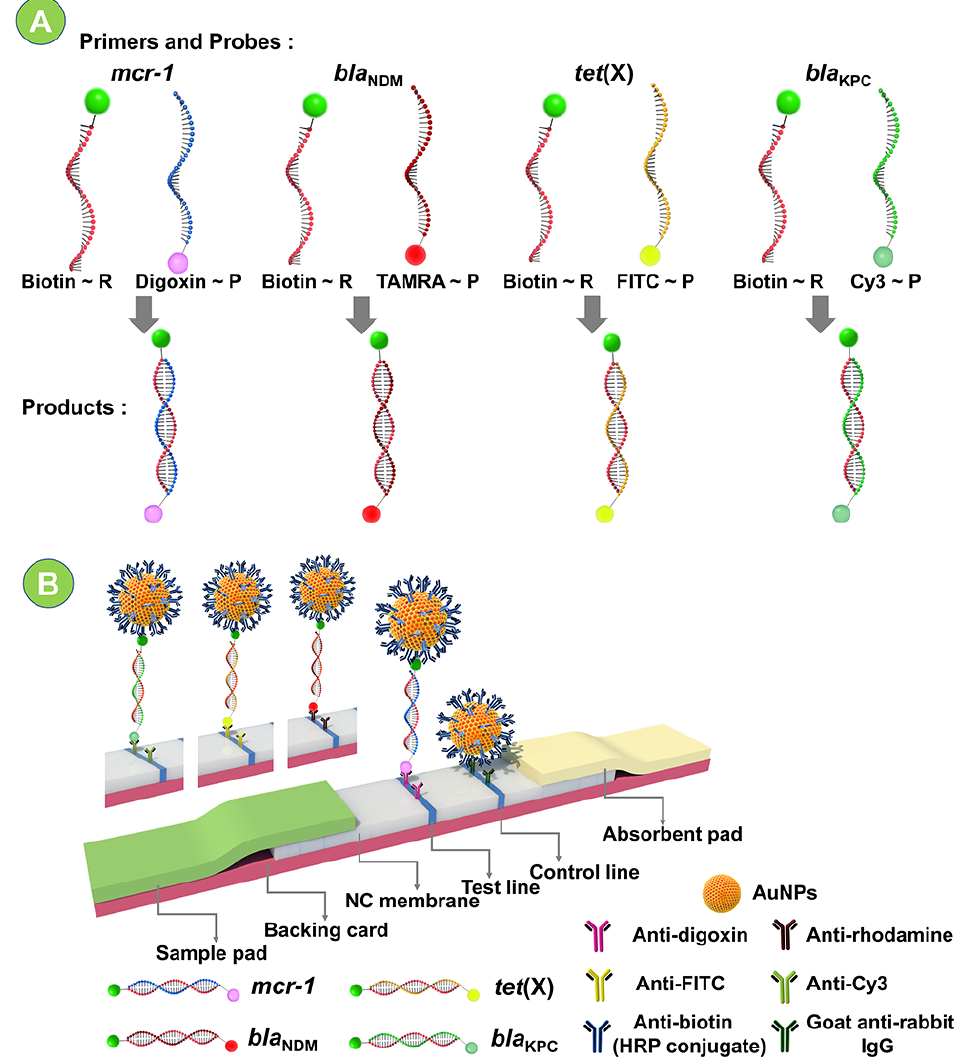
Figure 1. Scheme of the cascade detection system. ( A ) Schematic illustration of RPA, ( B ) HRP- catalyzed LFIA.